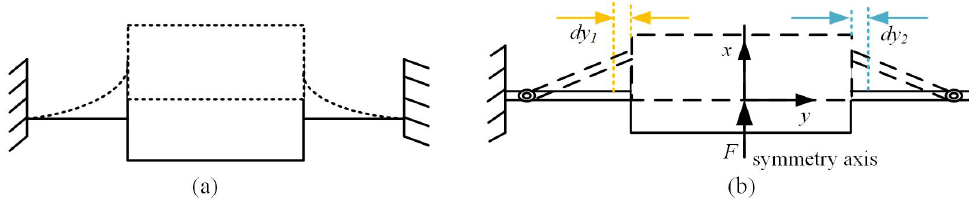
Figure 3. Symmetrical compliant mechanism. (a) Schematic diagram. (b) PRBM.